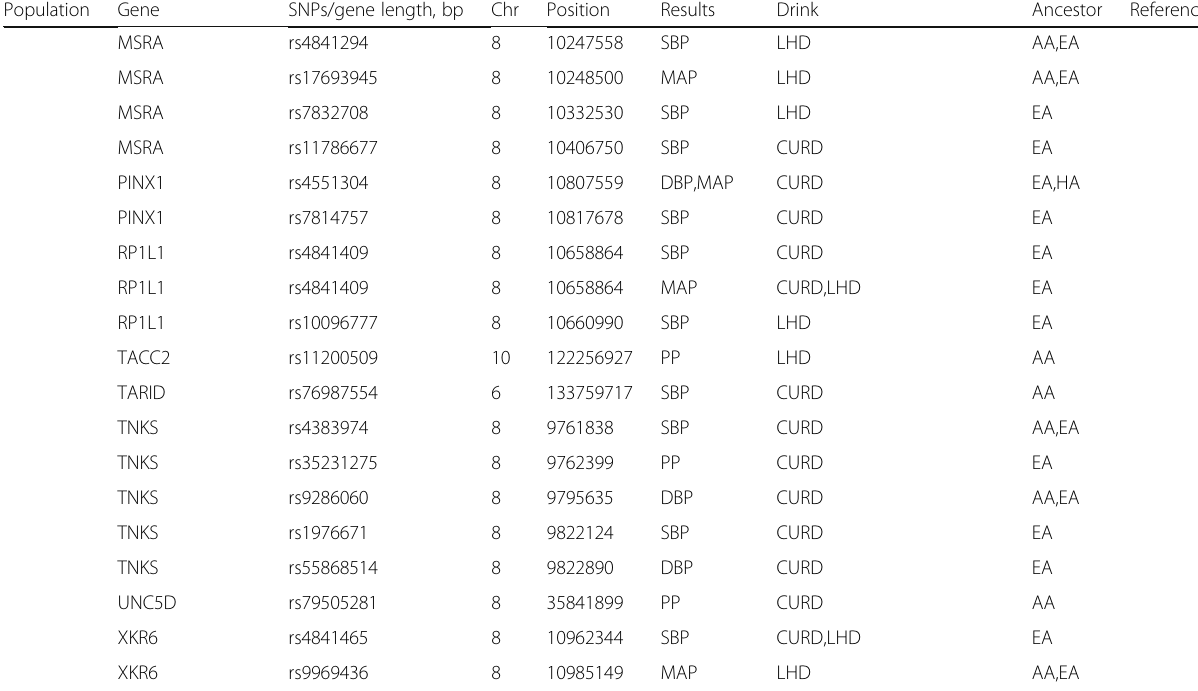
Table 4 Review for interaction of gene and alcohol intake on hypertension (Continued)